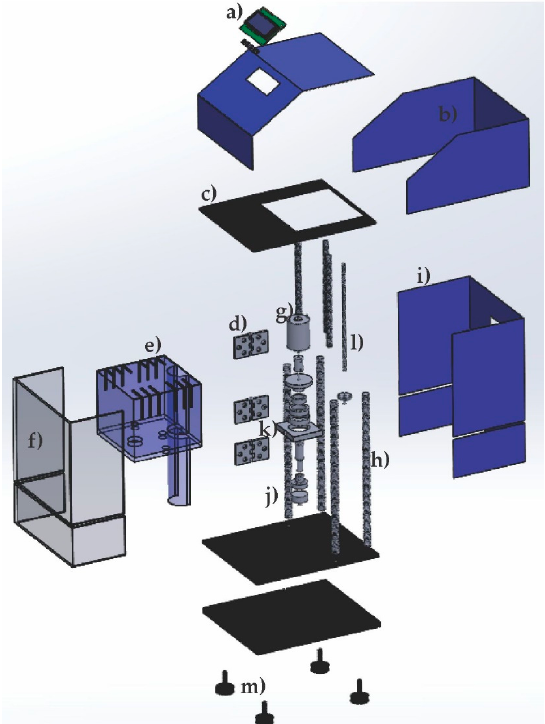
Figure 5. Design of the proposed rheometer and components. ( a ) LCD display; ( b ) sheet metal casing; ( c ) steel plates; ( d ) ball bearing hinge; ( e ) container box (the motor and electronic accessories); ( f ) acrylic protective cover; ( g ) motor; ( h ) steel rods; ( i ) galvanized sheet; ( j ) shaft, tip, and sample container assembly; ( k ) Nylamid couple, inertia flywheel, Nylamid bearing holder, and bearing assembly; ( l ) threaded rod; and ( m ) adjustable leg leveler.